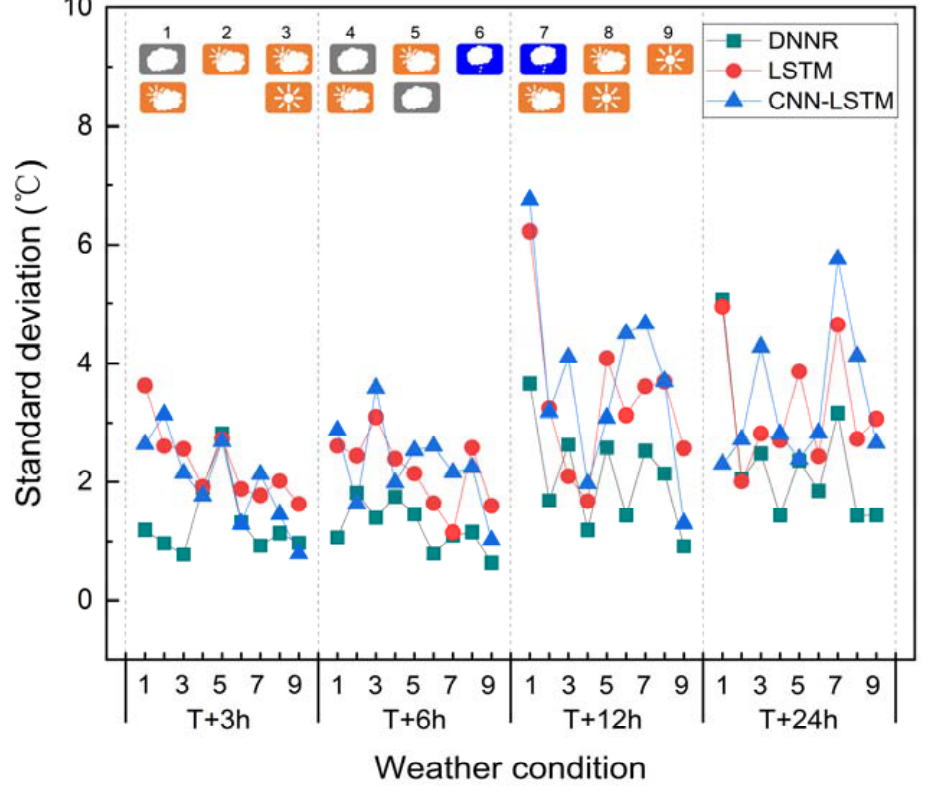
Figure 19. The statistics of the error distribution between the predicted value of the best model and the actual value for Greenhouse B temperature.